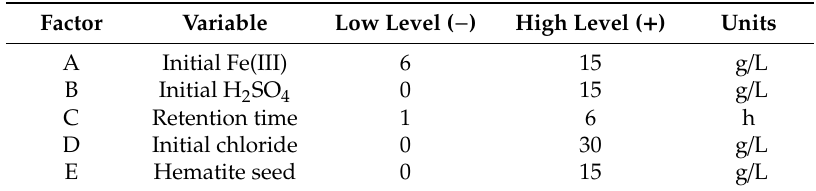
Table 1. Variables and their ranges used for the factorial design experiments. Hematite was the dominant precipitate within these